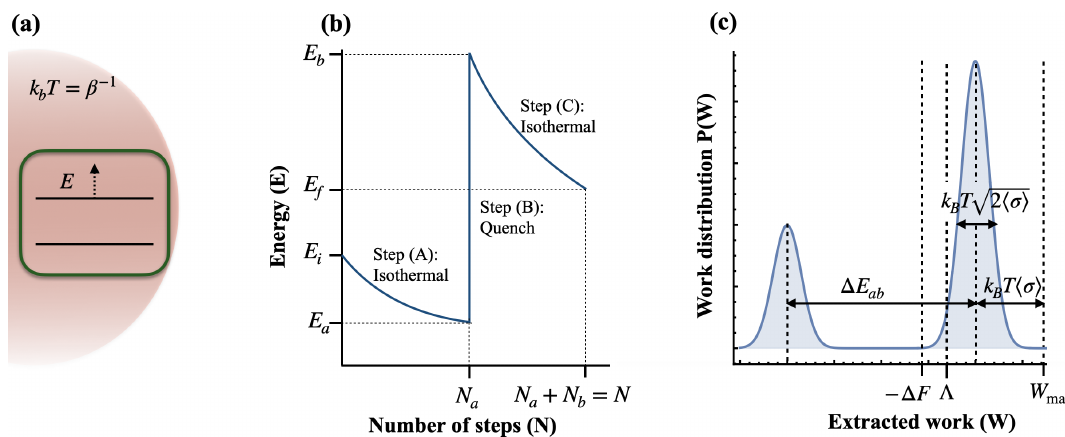
Figure 1: (a) Set-up considered in this work: Work extraction through a driven two- level system in contact with a thermal bath at inverse temperature β (see also Sec.